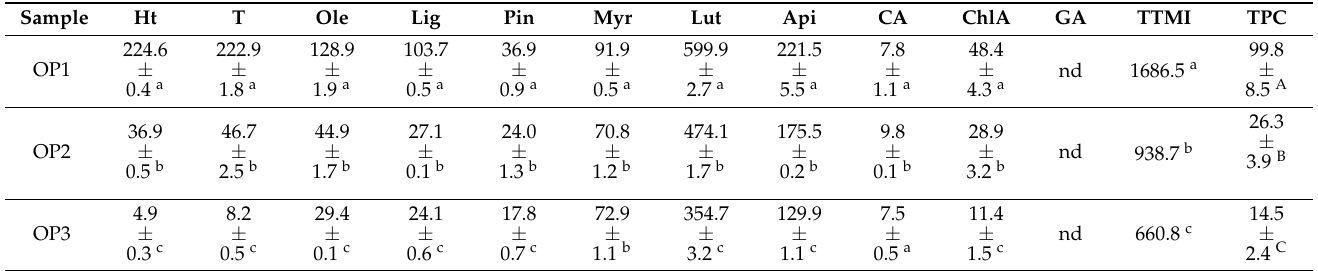
Table 1. Phenolic composition ( µ g/g dry weight) and TPC (mg of GAE/g extract) of the three OP